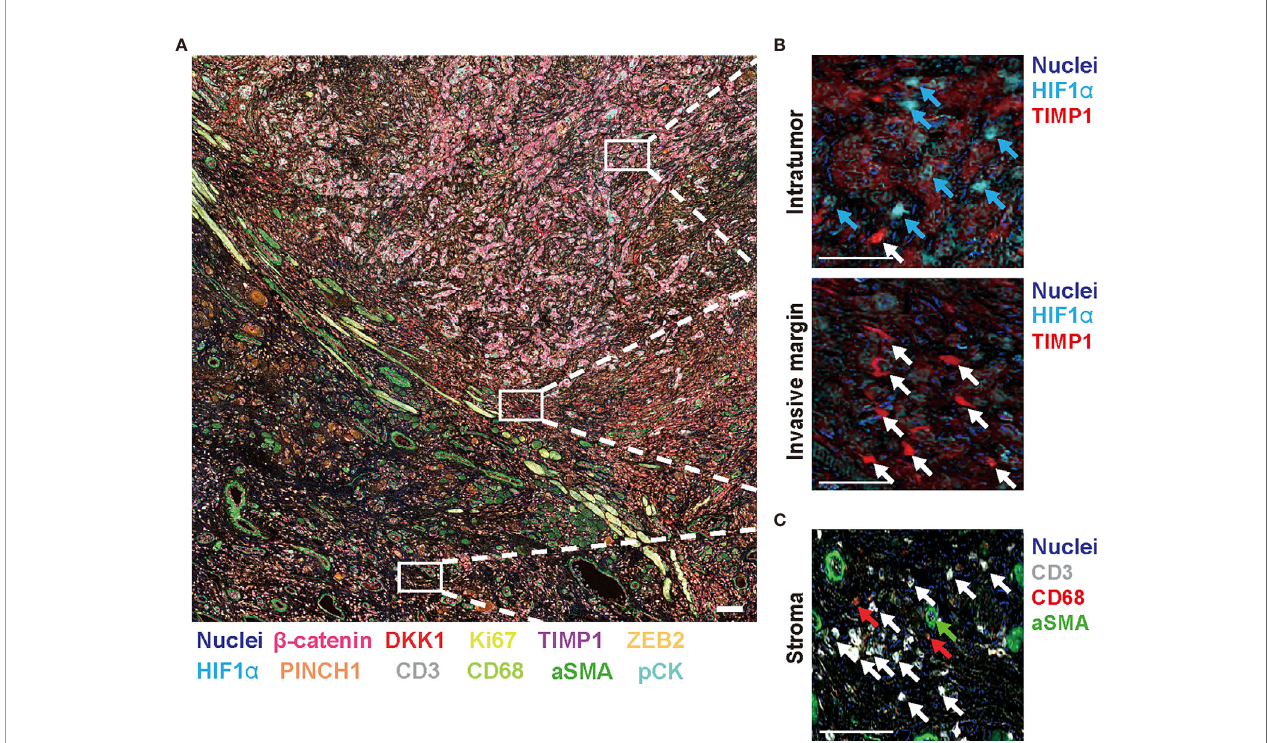
FIGURE 5 | Fourteen-marker multiplex IHC panel to visualize prognostic tumor cell biomarkers and immune/stromal cells in a single FFPE tissue. A FFPE tissue of tongue SCC is visualized by the established 14-marker multiplex IHC. (A) Representative 12-color composite images are shown. Biomarkers and colors are shown at the bottom. Scale bar = 100 µm. (B) Top and bottom panels present expression of HIF1 a and TIMP1 in the intratumor and invasive margin regions, respectively. Blue and white arrows depict HIF1 a + cells and TIMP1 + cells, respectively. (C) Immune markers (CD3 and CD68) and aSMA + cells in stroma region are shown. White, red, and green arrows present CD3 + , CD68 + , and aSMA + cells, respectively. Biomarkers and colors are shown at the right. Scale bars = 10 µm. Corresponding single-marker images are shown in Supplementary Figure 3